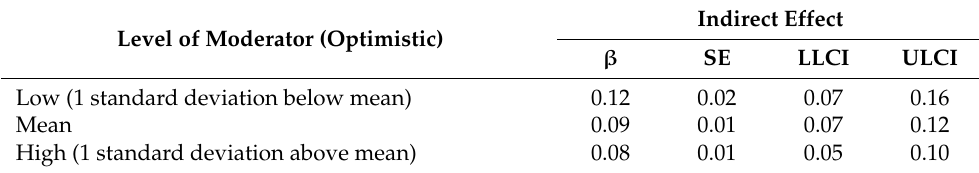
Figure 3. Optimistic moderated the relationship between health anxiety and cyberchondria. Table 5. Conditional indirect effect analysis at levels of the Moderator